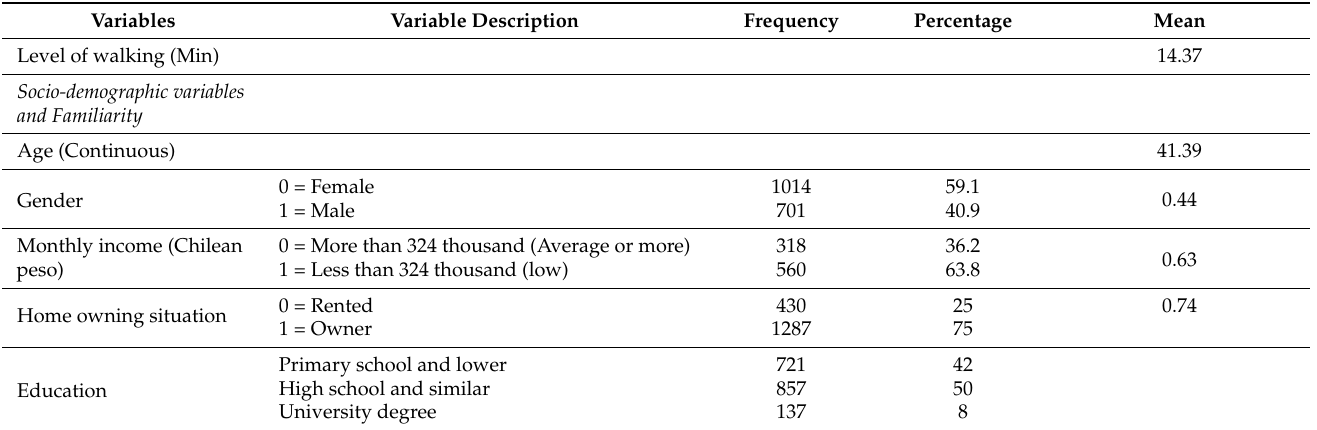
Table 1. Descriptive statistics of socio-demographic variables, social, and built environment factors (N =